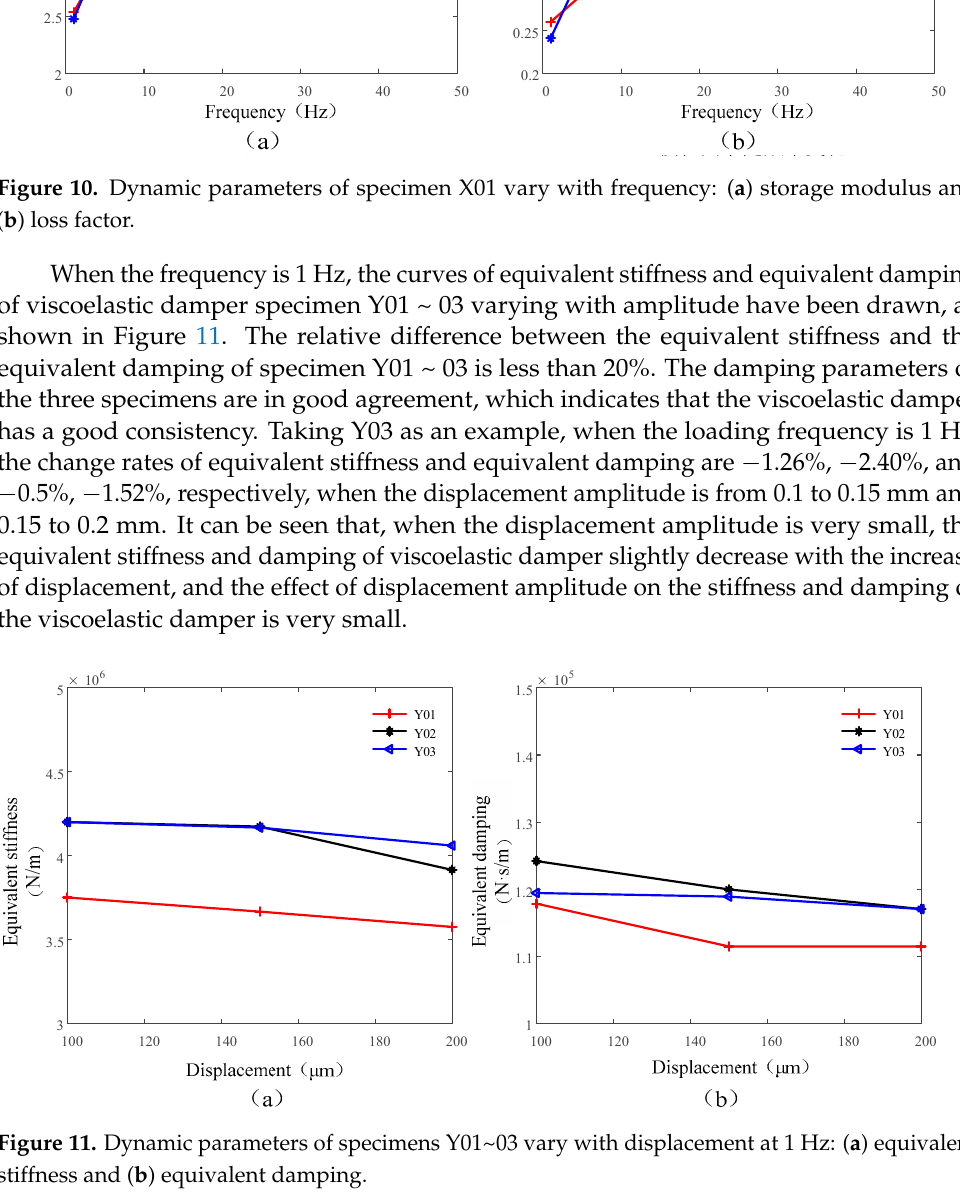
stiffness and ( b ) equivalent damping.